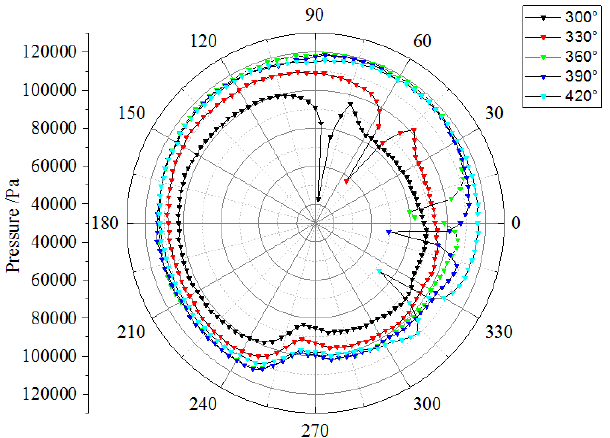
Figure 19. Pressure distribution at the impeller outlet under designed flow rate condition.